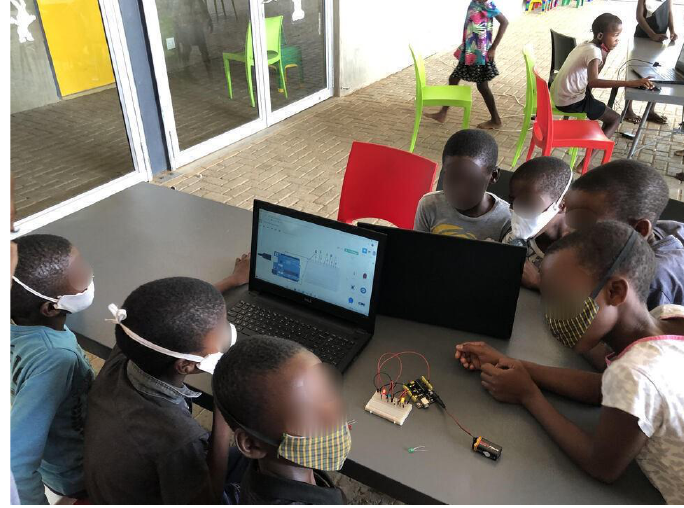
13 of 20 Figure 6. The three teams at the ER workshop. 4.2.2. Task 2: Turning on the LED light on Arduino Board